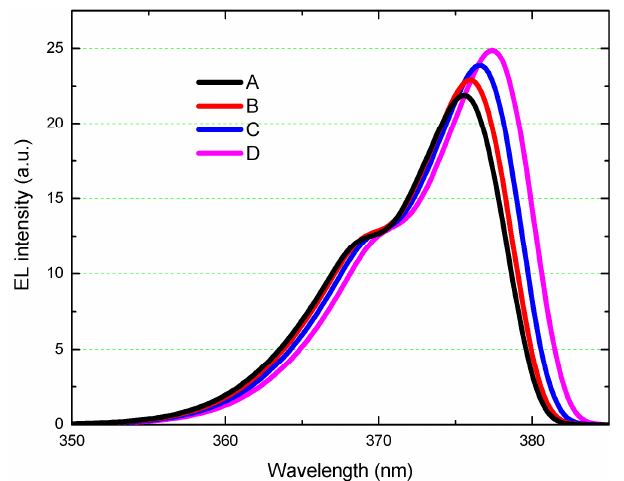
Figure 2. EL spectra of samples A , B , C and D under 100-mA injection current.